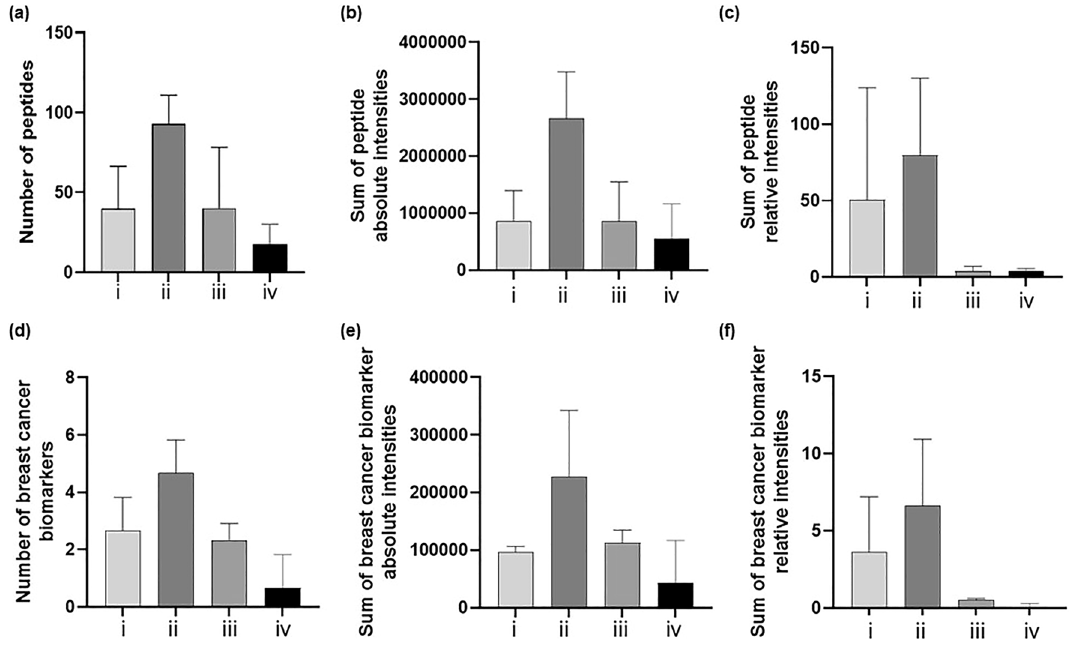
Figure 2. Column graph showing the number, the absolute and relative intensities of either all peptides peaks ( a – c , respectively) or potential breast cancer biomarkers ( d – f , respectively) present in fingermarks spotted with several digestion conditions (n = 3): (i) 25 µg/mL trypsin containing 0.01% v/v glycerol and incubated in ◦ Tupperware box containing saturated K 2 SO 4 solution at 50 C for 2 h; panel (ii) : fingermark spotted using